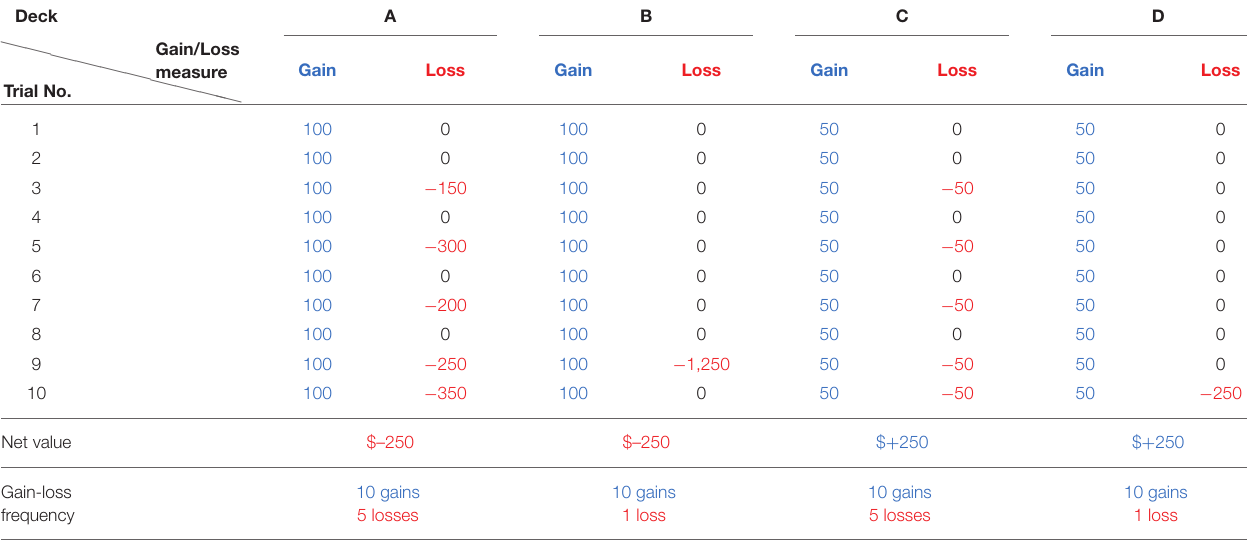
TABLE 1 | The first circle of 10 trials in the gain/loss structure of the IGT. Deck A B C D XXXXXXXXXX Gain/Loss measure Trial No.